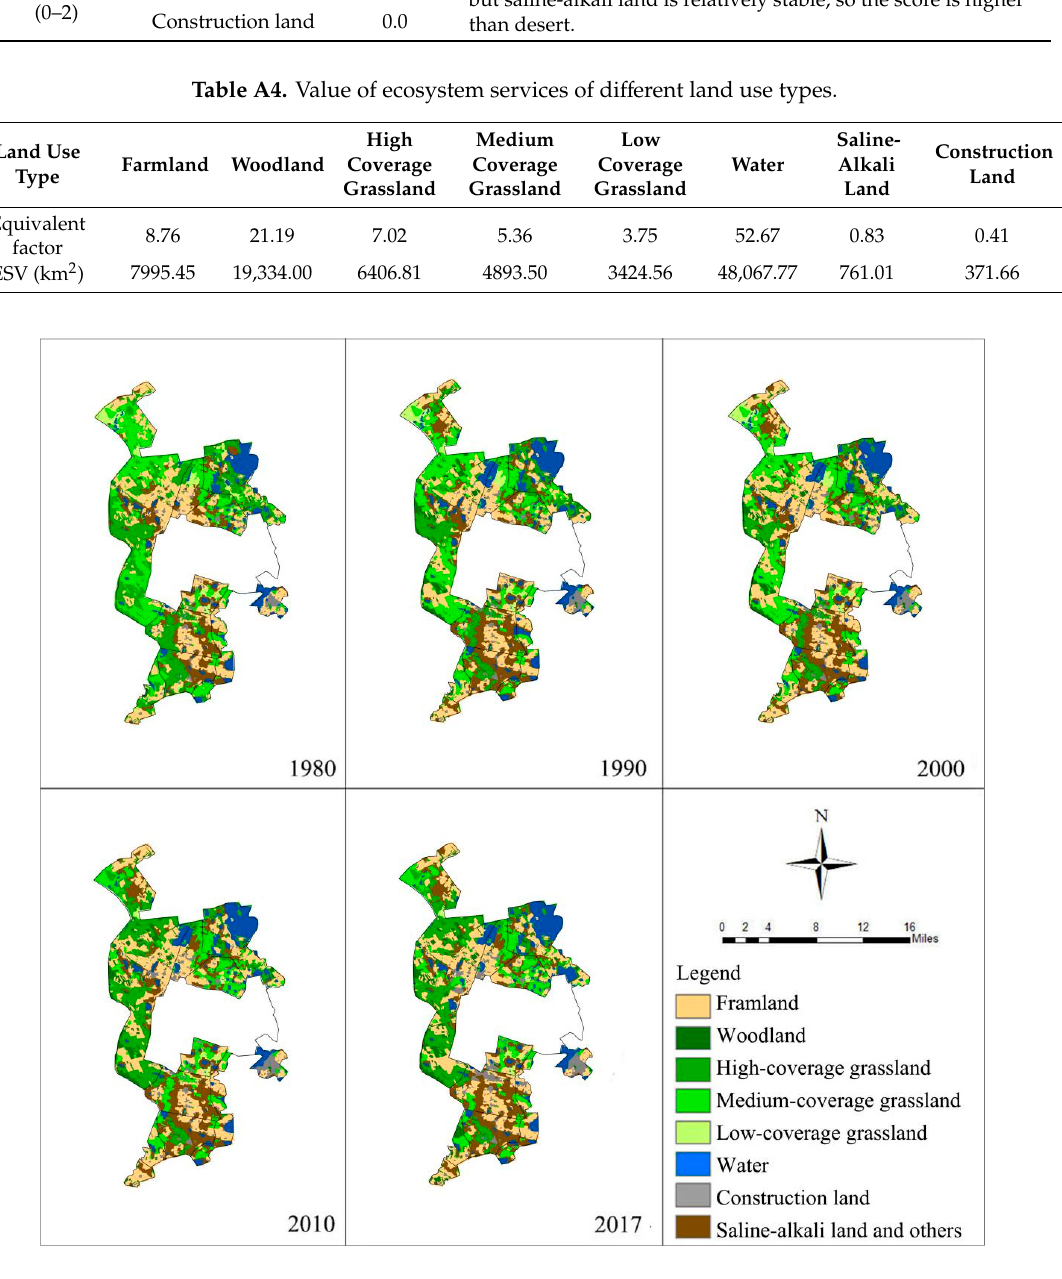
Figure A1. Classification of Land Use and Land Cover from 1980 to 2017.